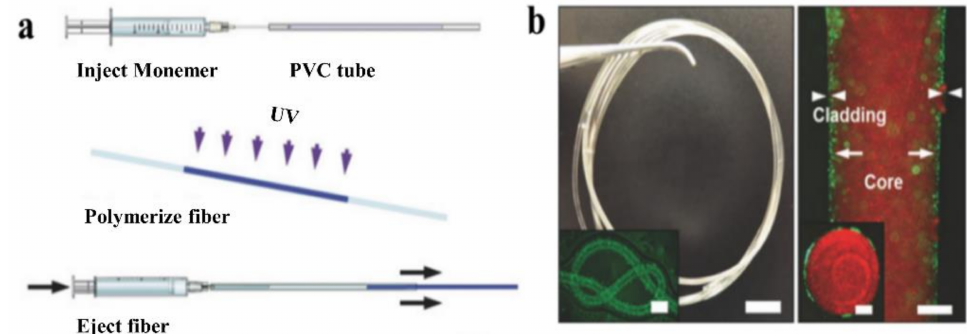
Figure 7. ( a ) A schematic showing the fabrication process of casting. (Reprinted with permission from ref. [46]). ( b ) Images of the obtained p(AM-co-PEGDA-co-3-APBA) based optical fiber. (Reprinted with permission from ref.